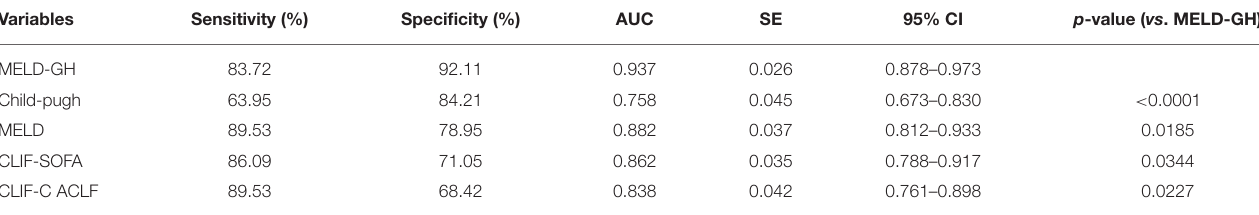
TABLE 4 | Performance of different prognostic models.